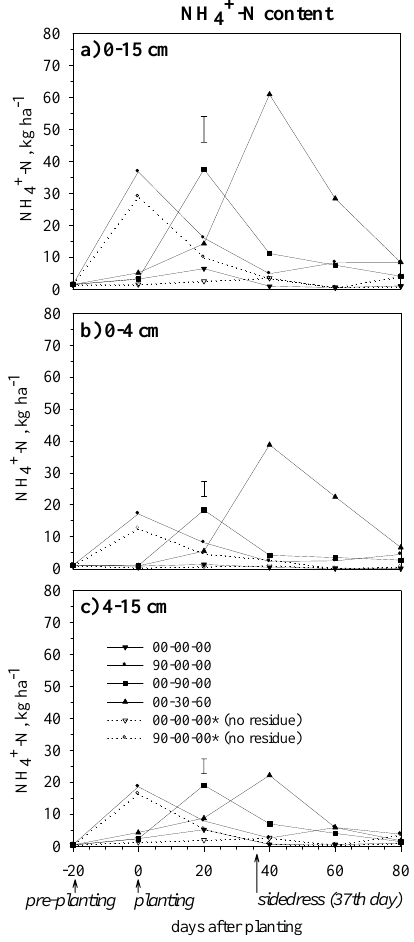
Figure 1. Amount of dry matter (a), N concentration Figure 2. Soil NH 4+ -N content in the 0–15 cm layer (b) and N content (c) in the surface oat residue (a), 0–4 cm layer (b) and 4–15 cm layer (c) from from the spreading on the soil until 80 days 20 days before until 80 days after maize after planting, as affected by the timing of N planting, as affected by the timing of N application. 00–00–00: control; 90–00–00: application. 00–00–00: control; 90–00–00: 90 kg ha -1 of N at pre-planting; 00–90–00: 90 kg ha -1 of N at pre-planting; 00–90–00: 90 kg ha -1 of N at planting; 00–30–60: 30 kg ha -1 90 kg ha -1 of N at planting; 00–30–60: 30 kg ha -1 of N at planting plus 60 kg ha -1 of N at of N at planting plus 60 kg ha -1 of N at sidedressing. Vertical bars refer to the Tukey sidedressing. Vertical bars refer to the Tukey LSD ( P < 0.05) within each evaluation time. LSD ( P < 0.05) of each evaluation. Table 1. Overall mean N concentration and C:N ratio of oat residue of the treatments during the experimental period Time N C:N ratio days after